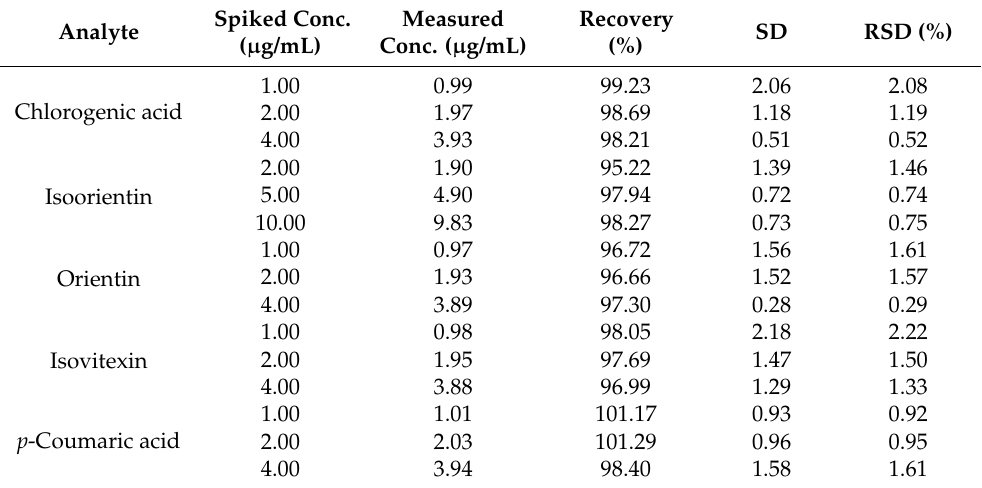
Table 3. Precision of the developed HPLC analysis method using 5 markers.